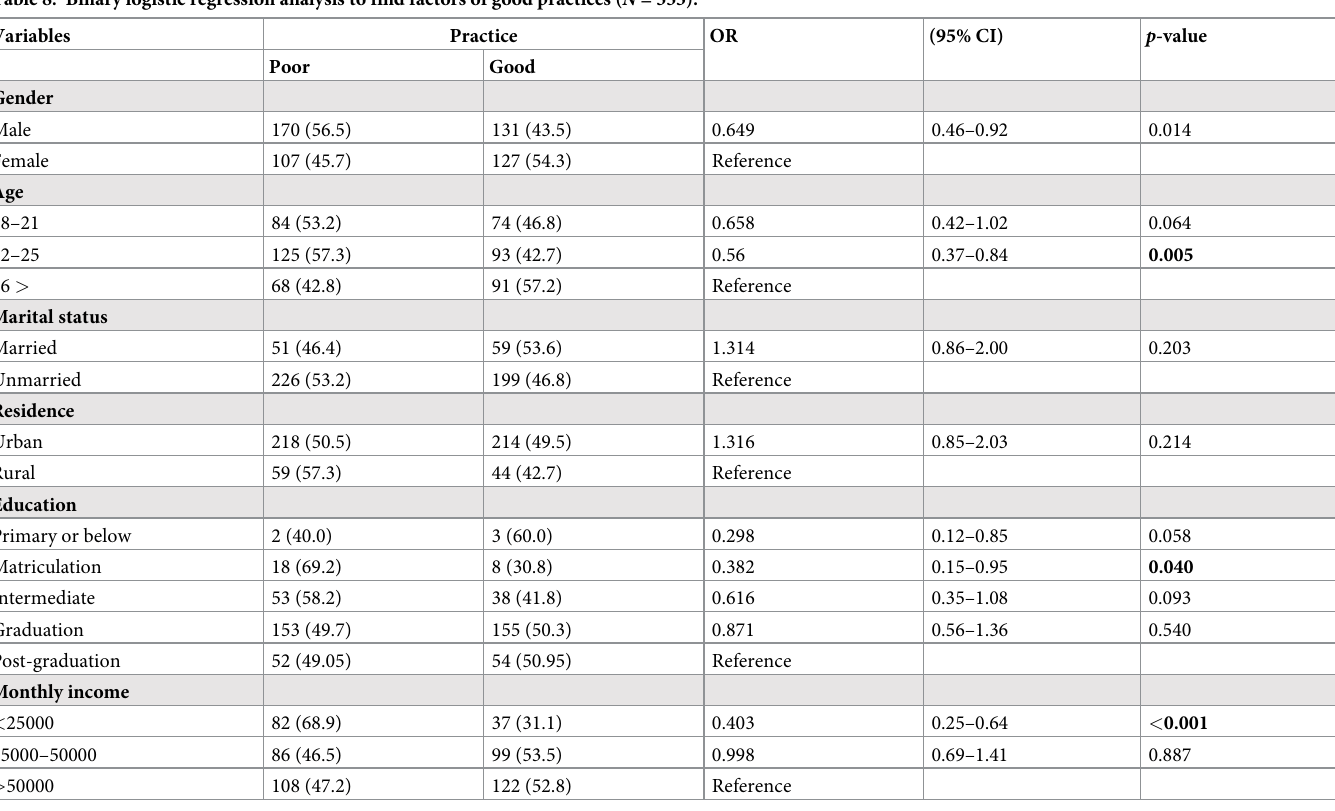
Table 8. Binary logistic regression analysis to find factors of good practices ( N =